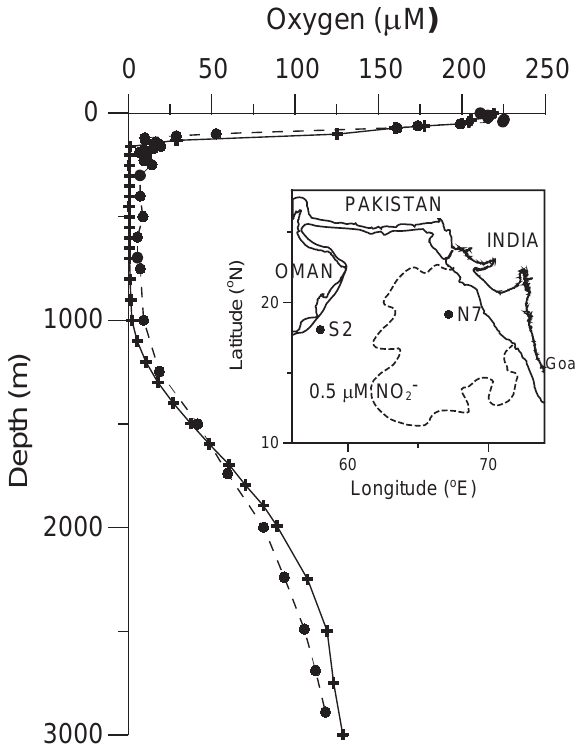
Fig. 8. Comparison of vertical profiles of O 2 at two sites one off the Omani margin (Sta. S2; 18.08 ◦ N, 58.03 ◦ E; circles joined by the dashed line) and the other close to the heart of the O 2 deficient zone (Sta. N7; 19.17 ◦ N, 67.17 ◦ E; crosses joined by the continu- ous line). The data were collected on US JGOFS Cruise TN045 during March-April, 1995. The inset shows station locations with reference to the suboxic zone bounded by the 0.2µM NO − (from Naqvi,